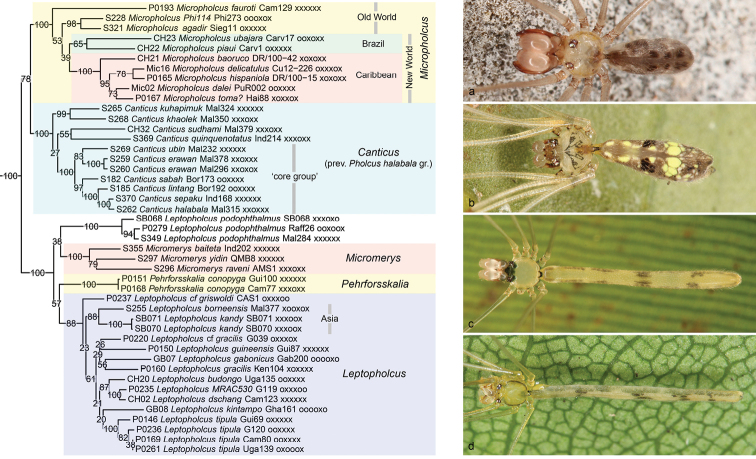
Micropholcus-Leptopholcus clade aMicropholcus sp. n. “Br15-152” (Brazil) bCanticussepaku (East Kalimantan) cMicromerysbaiteta (West Papua) dLeptopholcusborneensis (Singapore).